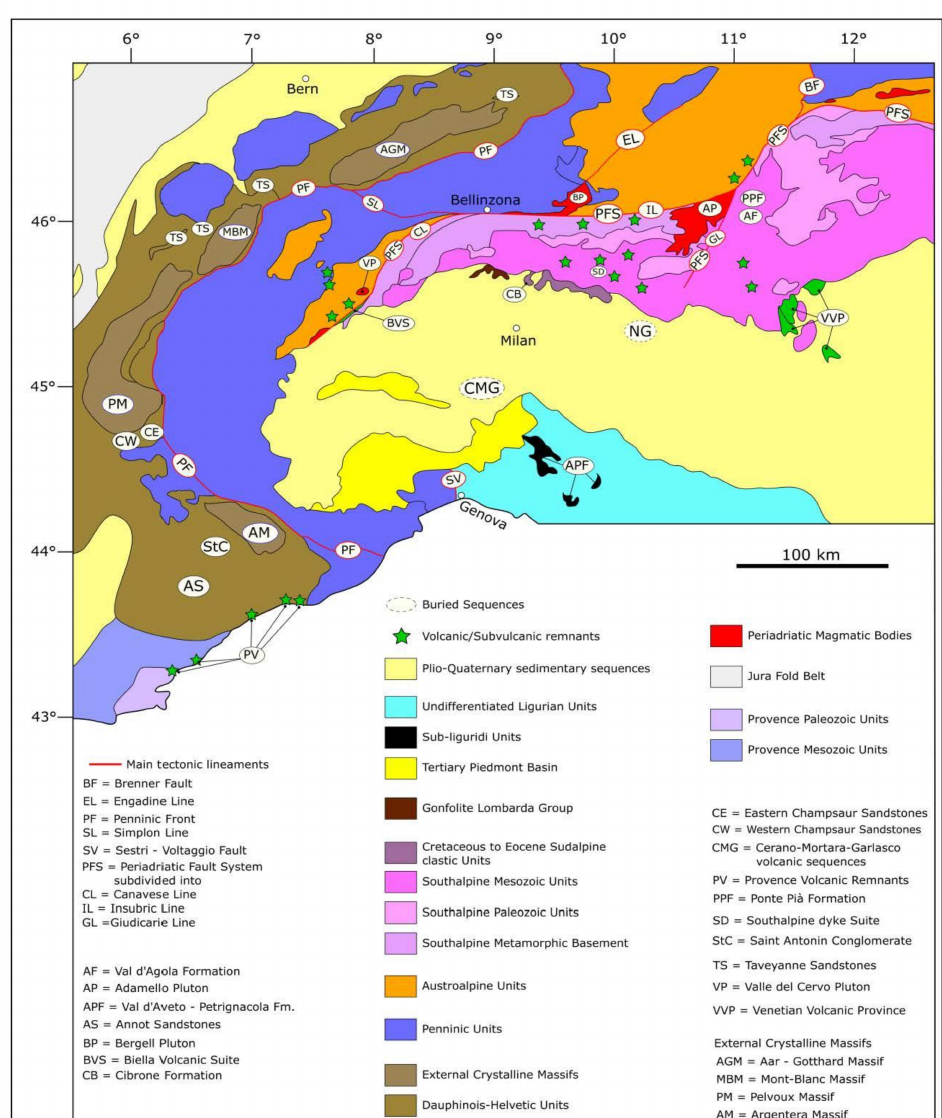
Figure 1. Geological map of the Alps, modified from